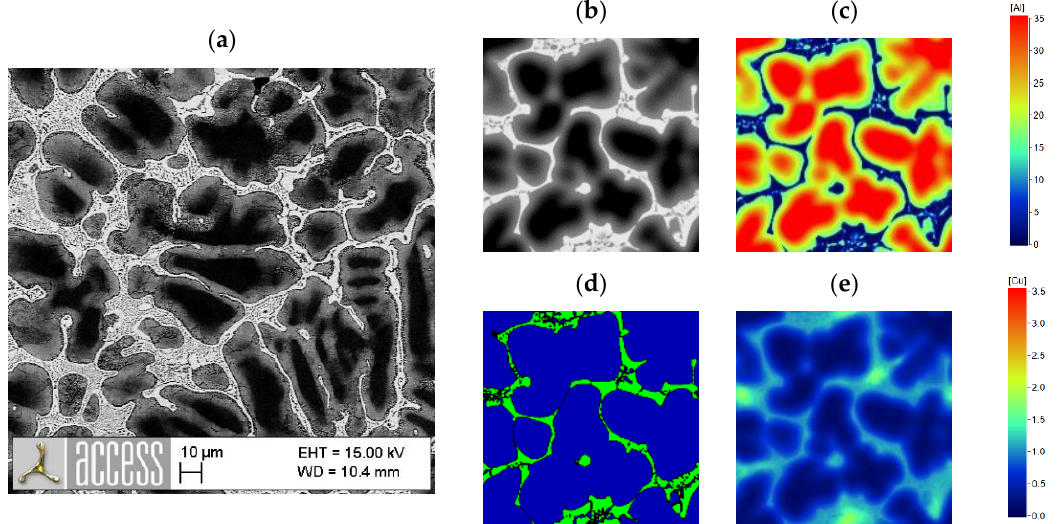
Figure 5. ( a ) Microstructure of ZnAl20Cu0.7 in BSE contrast; ( b – e ) simulated microstructure of ZnAl20Cu0.7. ( b ) Al (gray scale, matched contrast), ( c ) Al concentration (wt.%), ( d ) phases (η green, β blue) and ( e ) Cu concentration (wt.%). Size of the 2D plane from the simulation: 100 µm × 100 µm.